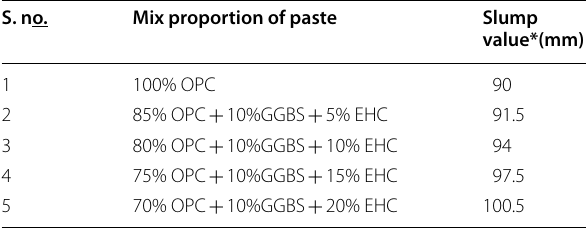
* Slump value (mm) with water/cement ratio of 0.36 including 3 ml/kg of HRWRA